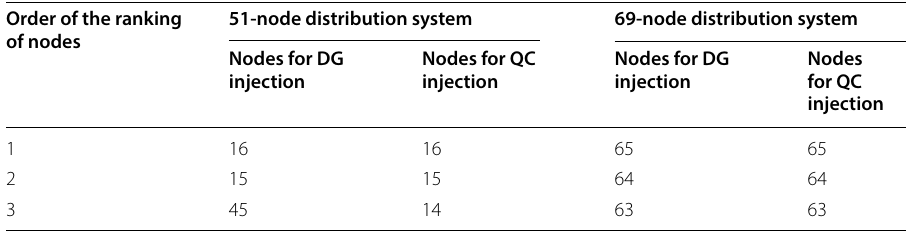
Table 2 Ranking of nodes using sensitivity analysis Order of the ranking of nodes